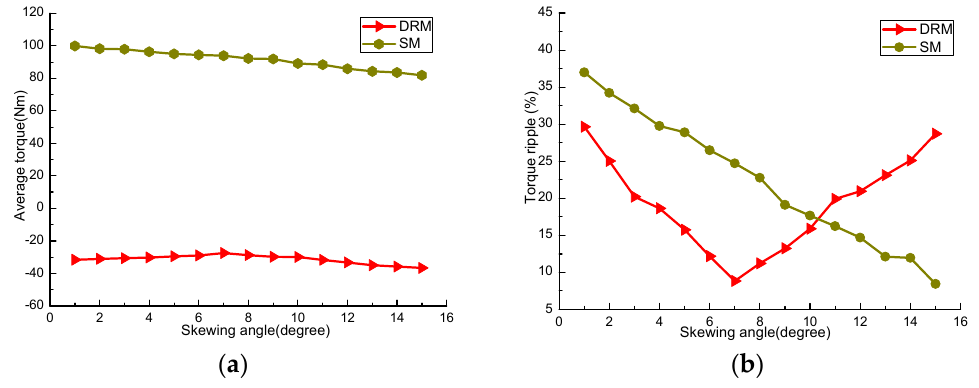
Figure 12. Average torque and torque ripple curve of DRM and SM with different skewing angles: ( a ) Average torque; ( b ) Torque ripple.